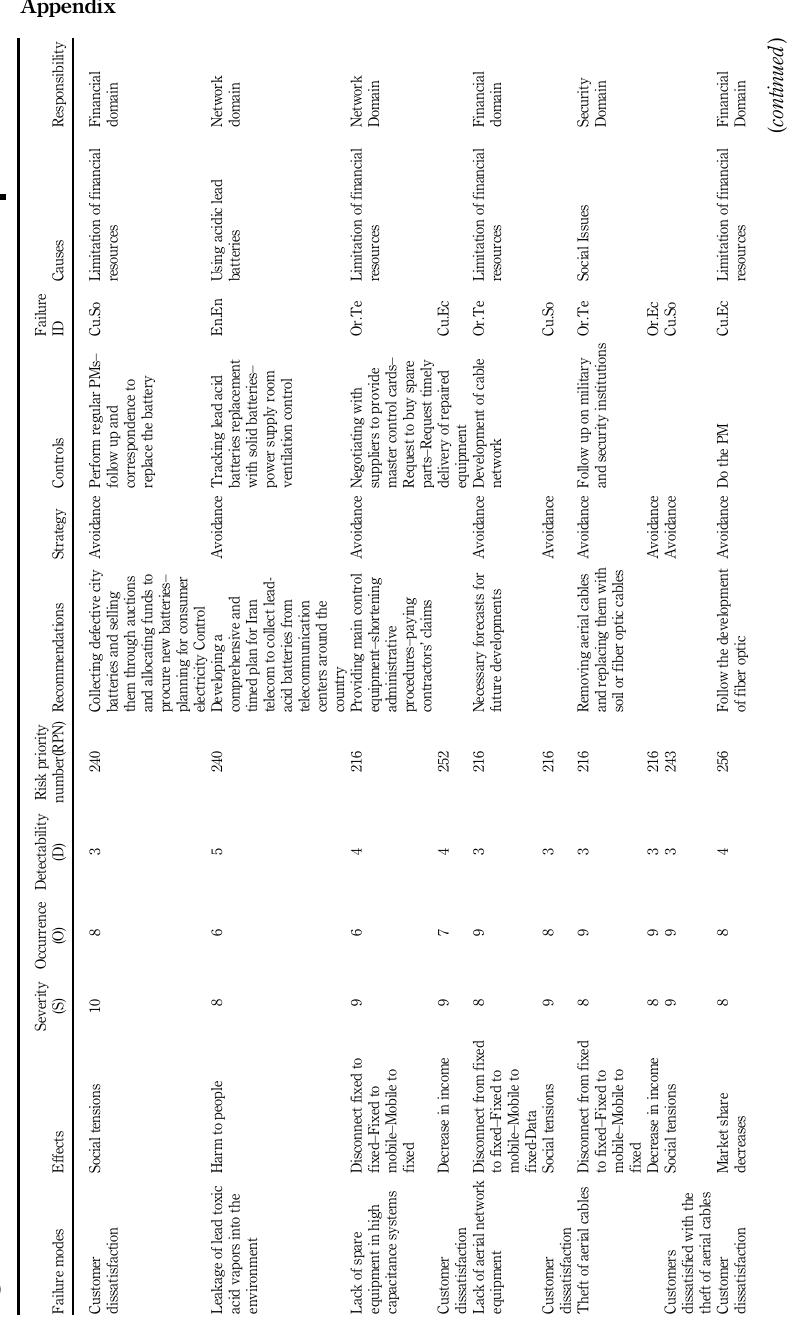
Table A1. Some examples of analyzed risks (PHA Pro 6 software